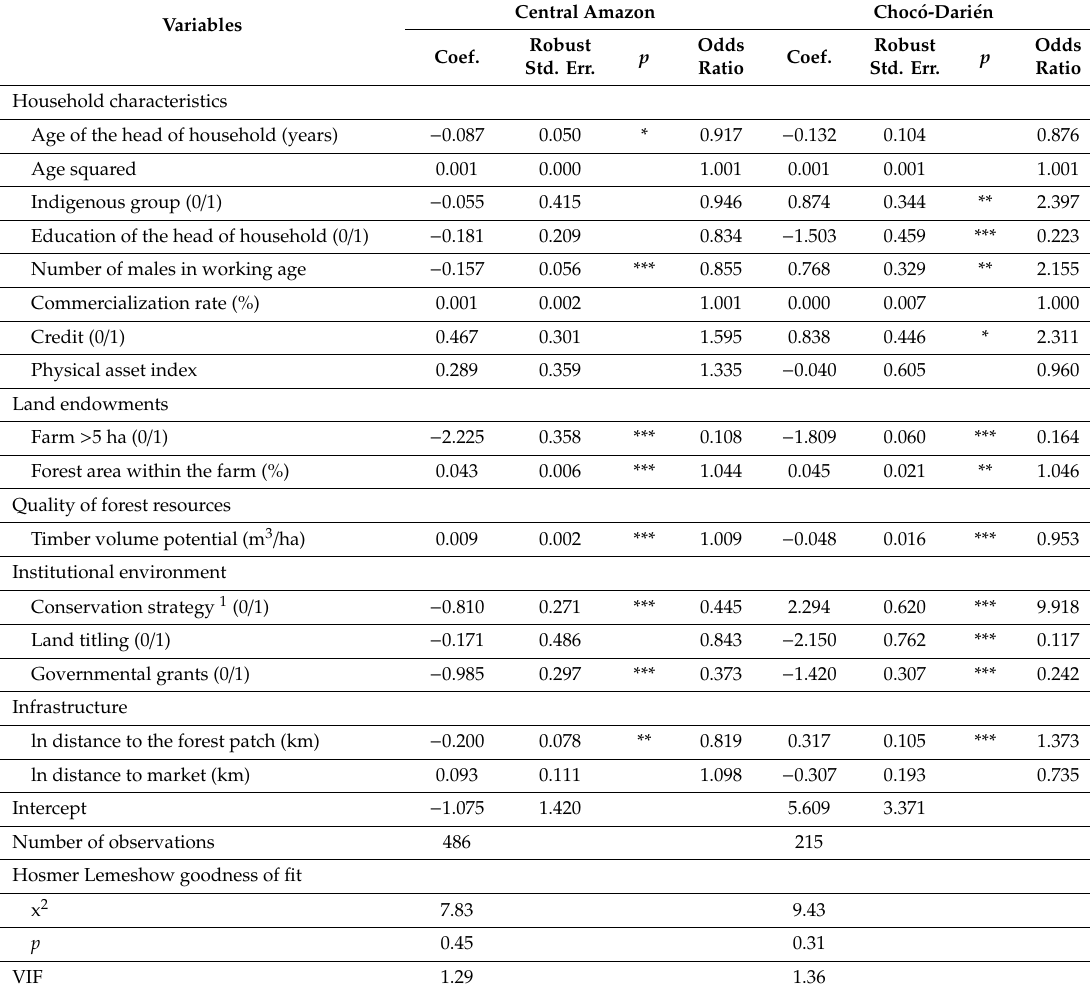
Table 2. Logit regression results of deforestation at household level for the Central Amazon and the Choc ó -Dari é n of